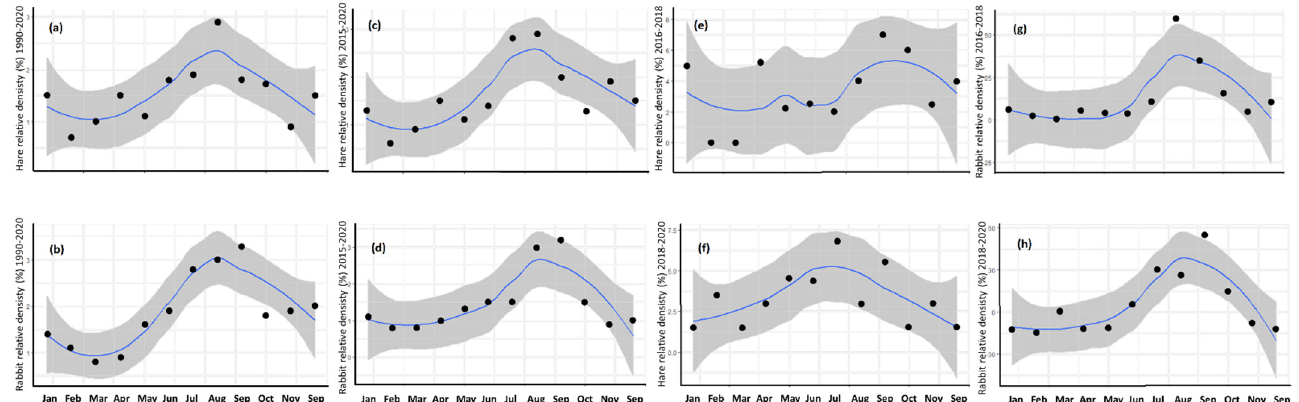
Figure 4. Monthly evolution of the relative density (%) of the hare ( Lepus granatensis ) and rabbit ( Oryctolagus cuniculus ) registered in a Mediterranean agricultural area (S. Spain). ( a , e ) Data from the full study period (1995–2020); ( b , f ) data from the period 2015–2020, in which a more intensive sampling was carried out. ( c , g ) Monthly dynamics for the hare, considering two intensively sampled after the myxomatosis outbreak. ( d , h ) The same for rabbit. Statistic: smooth.